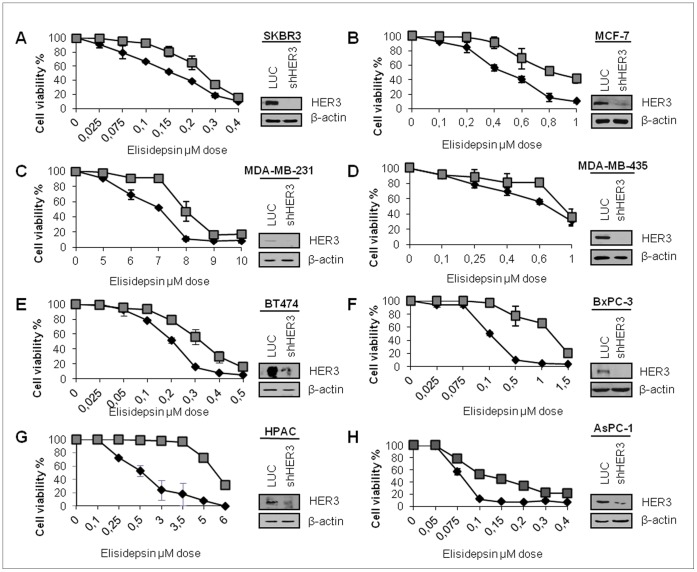
Loss of HER3 expression decreases the sensitivity to elisidepsin treatment.Cell viability after treatment with various concentrations of elisidepsin for 72 h was determined in SKBR3 (A), MCF-7 (B), MDA-MB-231 (C), MDA-MB-435 (D), BT474 (E), BxPC-3 (F), HPAC (G) and AsPC-1 (H) cells. HER3 expression was downregulated with shRNA (grey squares); LUC shRNA transfected cells were used as the control (black diamonds). Mean, SD, and IC50 values are shown from three independent experiments. Cell viability was measured using a crystal violet assay. Before performing the viability experiments, all cell lines were checked by western blot using 50 µg of protein to confirm their levels of HER3 expression.